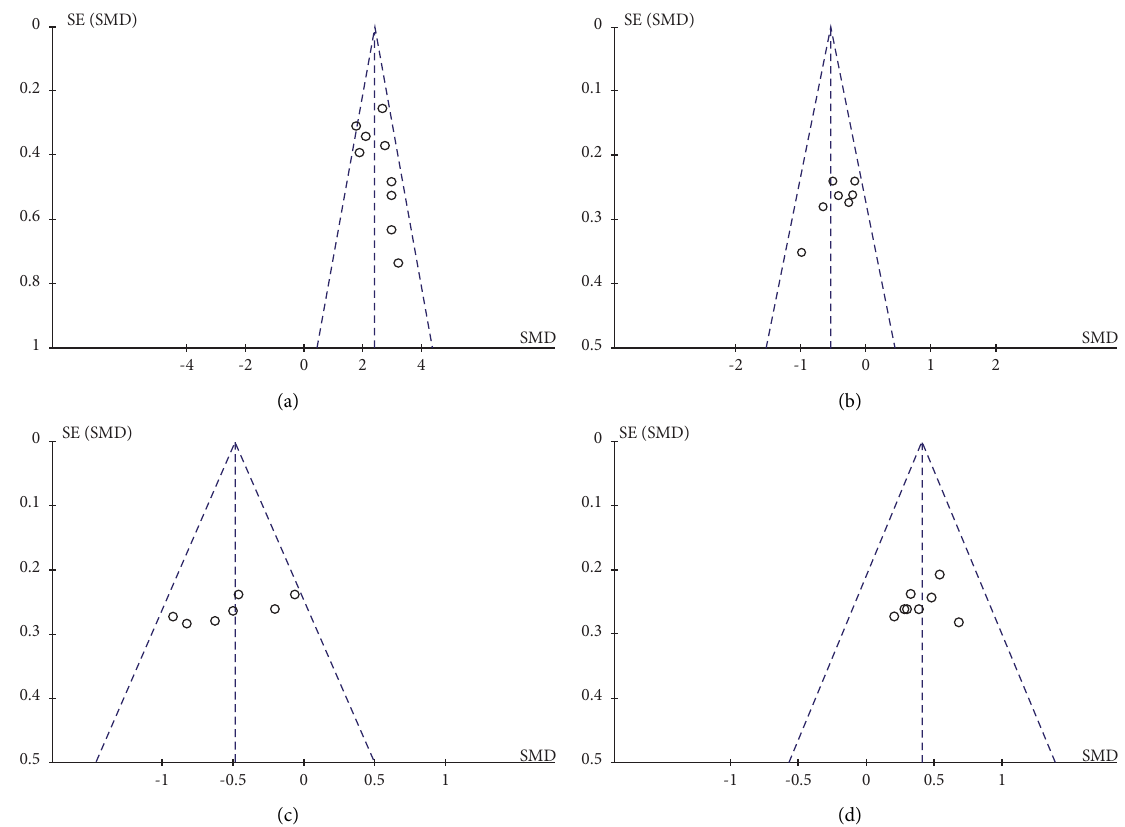
Figure 4: Funnel plots for (a) the serum 25(OH)D level, (b) the serum TG level, (c) the serum LDL level, and (d) the serum HDL